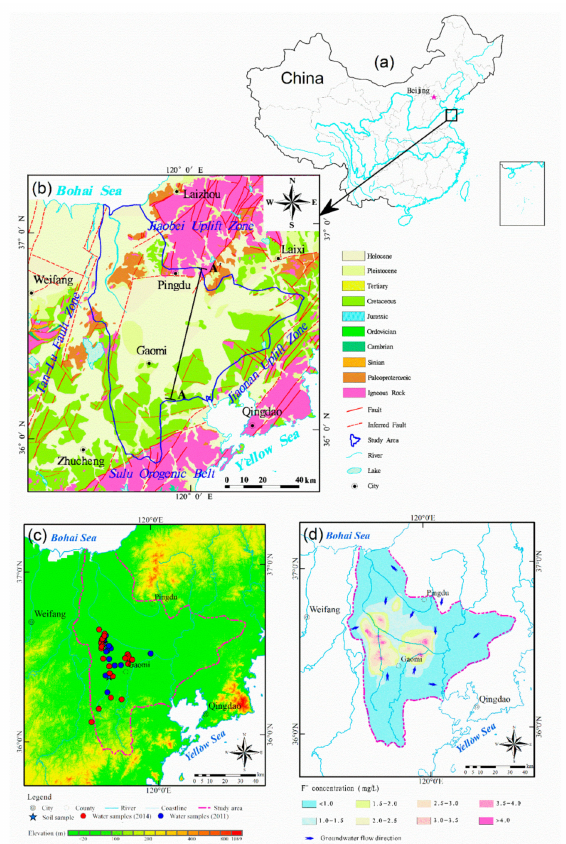
Figure 1. Survey of the Jiaolai Basin, Jiaodong Peninsula, eastern China. ( a ) location of study area, ( b ) stratigraphy and geological structures [51–53], ( c ) geomorphology and locations of water and soil samples, ( d ) fluoride distribution in